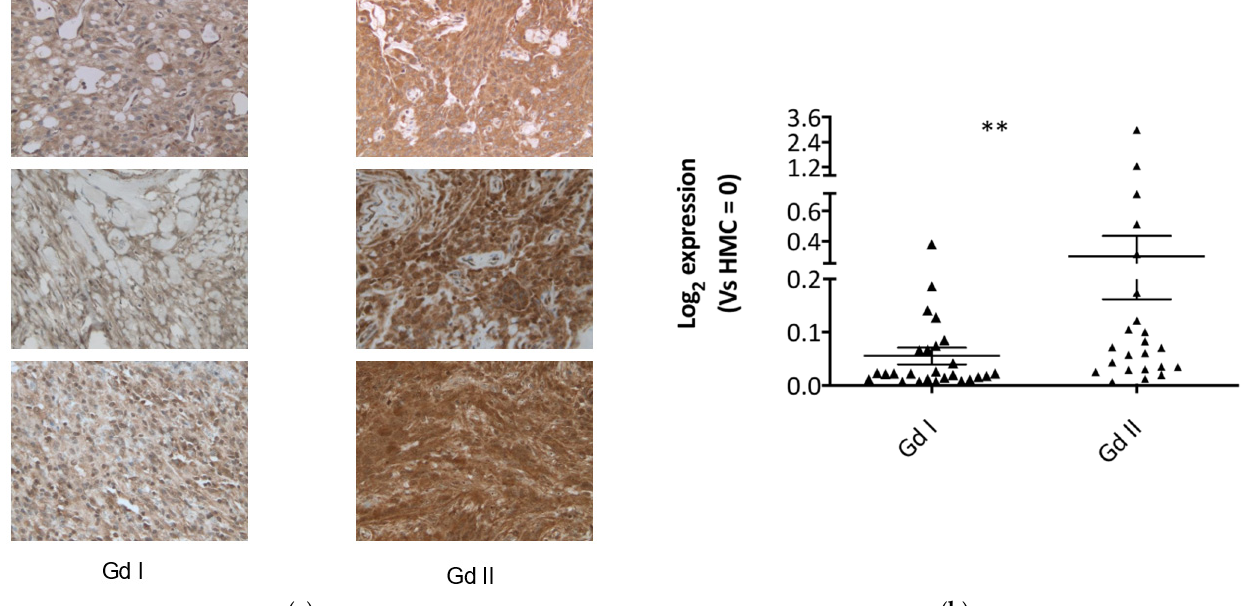
Figure 2. Fibulin-2 and FBLN2 are significantly overexpressed/upregulated in grade II compared to grade I meningioma tissue. ( a ) Representative immunohistochemistry images for Fibulin-2 staining in grade I and II meningiomas at 200 × magnification. Staining was diffusely cytoplasmic in tumour cells, and more intense in the grade II meningioma sections; ( b ) gene expression analysis by RT-qPCR of FBLN2 in meningioma tissue is reported. Data shown as log 2-fold change (FC) for grade I ( n = 26) and grade II ( n = 23) meningiomas. Data presented as mean ± SEM, ** p < 0.01.